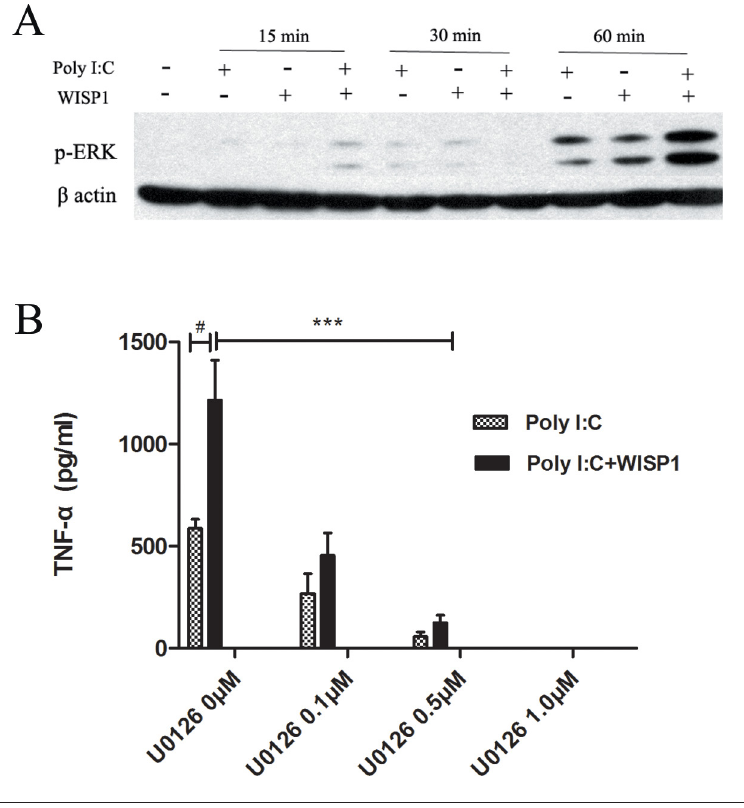
Figure 9. Effects of WISP1 and poly(I:C) on ERK phosphorylation in macrophages (A) Peritoneal macrophages isolated from C57BL/6J mice were treated with WISP1 (10 μ g/mL) or poly(I:C) in serum free medium for 15, 30 and 60 min. ERK phosphoryla- tion was detected by Western blot. Effects of an ERK inhibitor, U0126, on WISP1 and poly(I:C)-induced TNF- α release in macrophages. (B) Peritoneal macrophage isolated from C57BL/6J mice were treated with WISP1 (10 μ g/mL) and poly(I:C) (5 μ g/mL) in the presence or absence of various concentrations (0–1.0 μ mol/L) of U0126 in serum free medium for 16 h. TNF- α levels in the supernatant were measured by ELISA. Data are presented as means ± SEM (n = 5) and compared by two-way ANOVA. For comparing the poly(I:C) + WISP1 group pretreated with U0126 0.5 μ mol/L with poly(I:C) + WISP1 untre ated with U0126 group *** P <